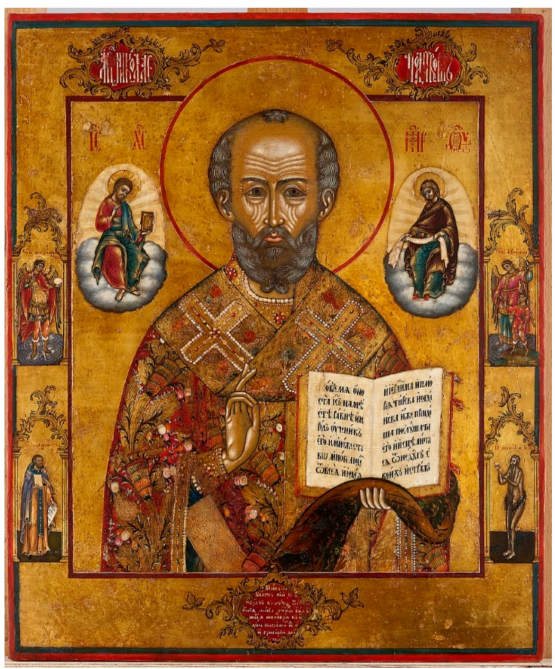
Figure 7. St. Nicholas Miracle Worker, Russia, Nevansk, workshop of the Old Believers, 1820, tempera on wood, 33.8 × 27.9 cm, National Museum in Warsaw, photo: Małgorzata Kwiatkowska.